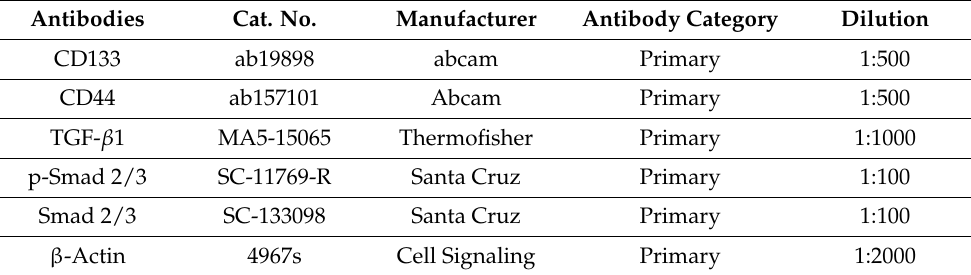
Table 2. List of